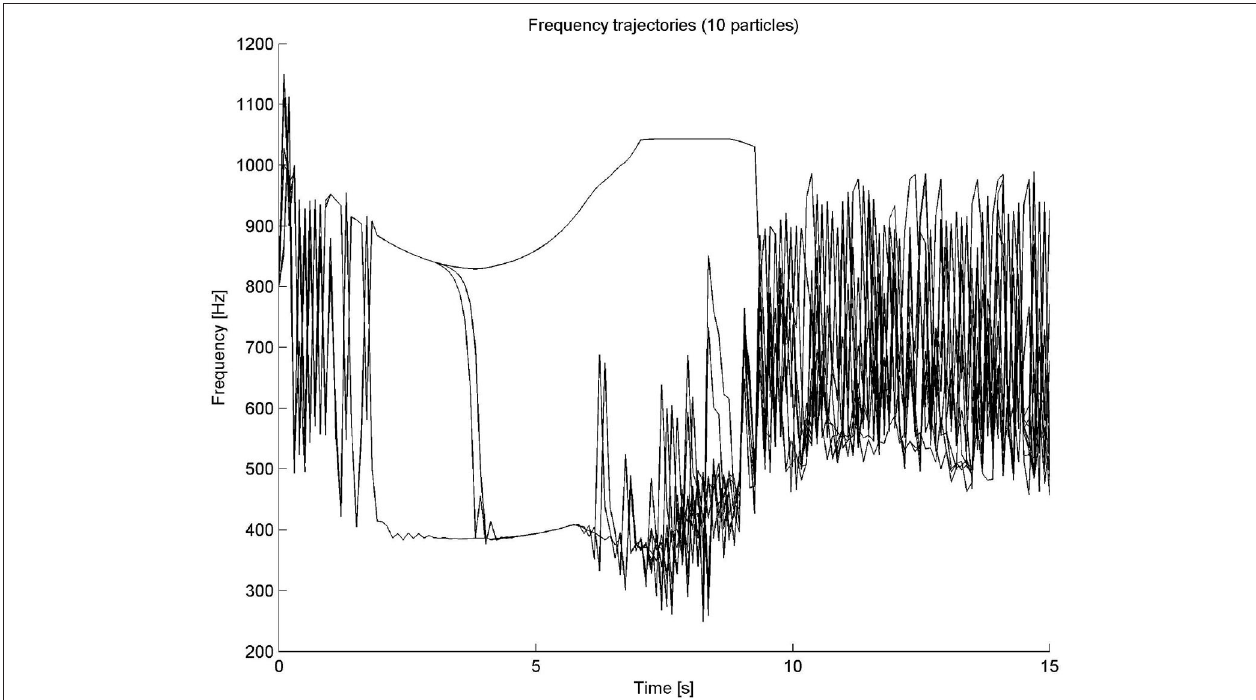
FIGURE 6 | Frequency trajectories in time for a 10-particle system. As it can be seen, highly complex behavior can be generated with a few simple if-then rules.